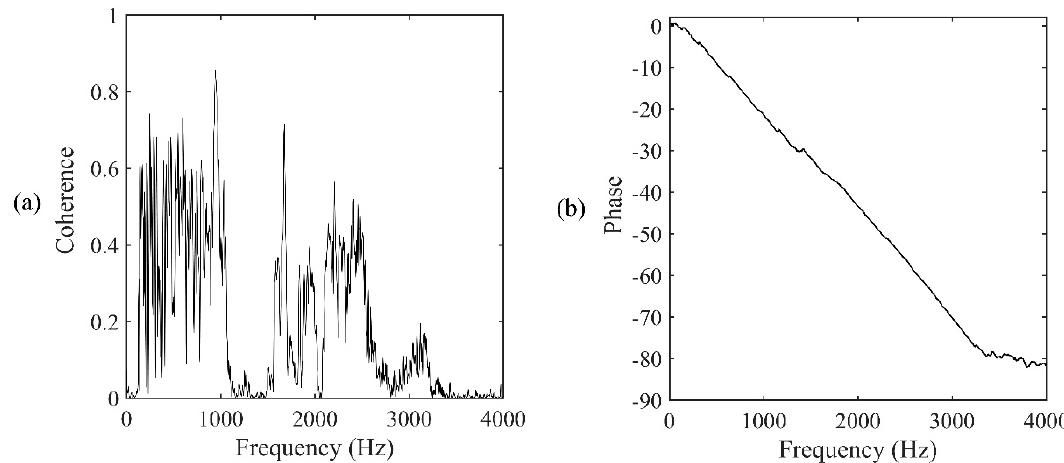
Figure 13. Frequency analysis of the signals measured at A2&A3: ( a ) Coherence function; ( b ) phase spectrum.